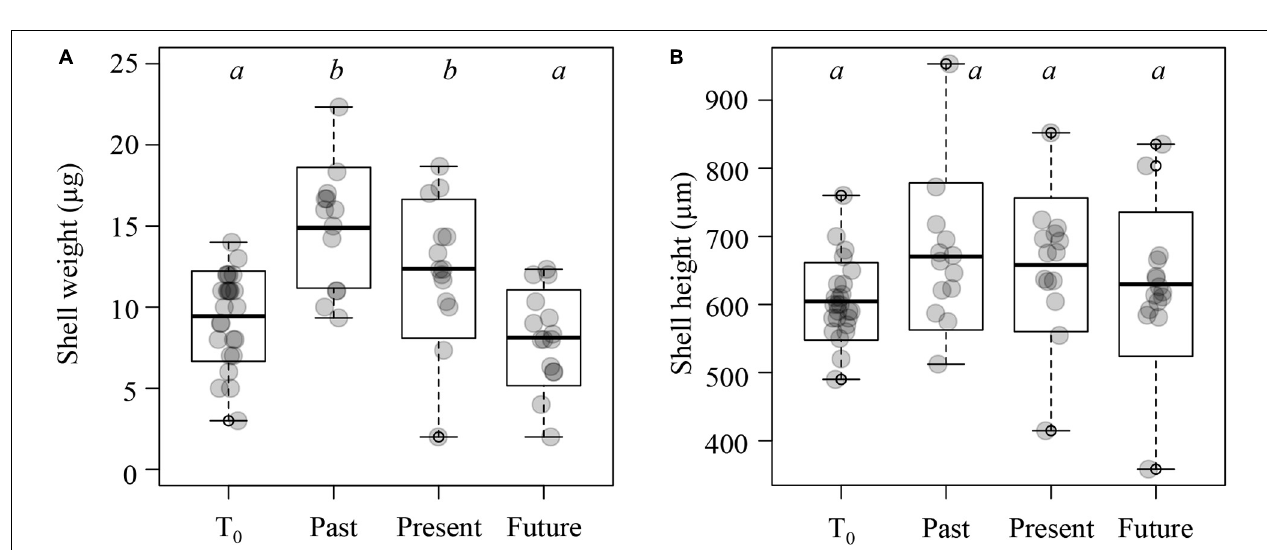
FIGURE 4 | Fluorescence images of shell calcification. (A) Individual that calcified across the entire shell (full glow). (B) Cross section of the same shell with full glow showing calcein incorporation in the shell wall. (C) Detail of cross section of the full glow shell with calcein incorporation (1) along the inner prismatic shell layer of the entire shell, except at (2) the region of apertural extension where calcein was integrated in all shell layers (prismatic, middle crossed- lamellar, inner prismatic). (D) Individual that showed accretionary shell growth at the aperture (apertural glow). (E) Cross section of the same shell with apertural glow showing calcein incorporation in all shell layers (prismatic, middle crossed- lamellar, inner prismatic) along the entire region of apertural extension.